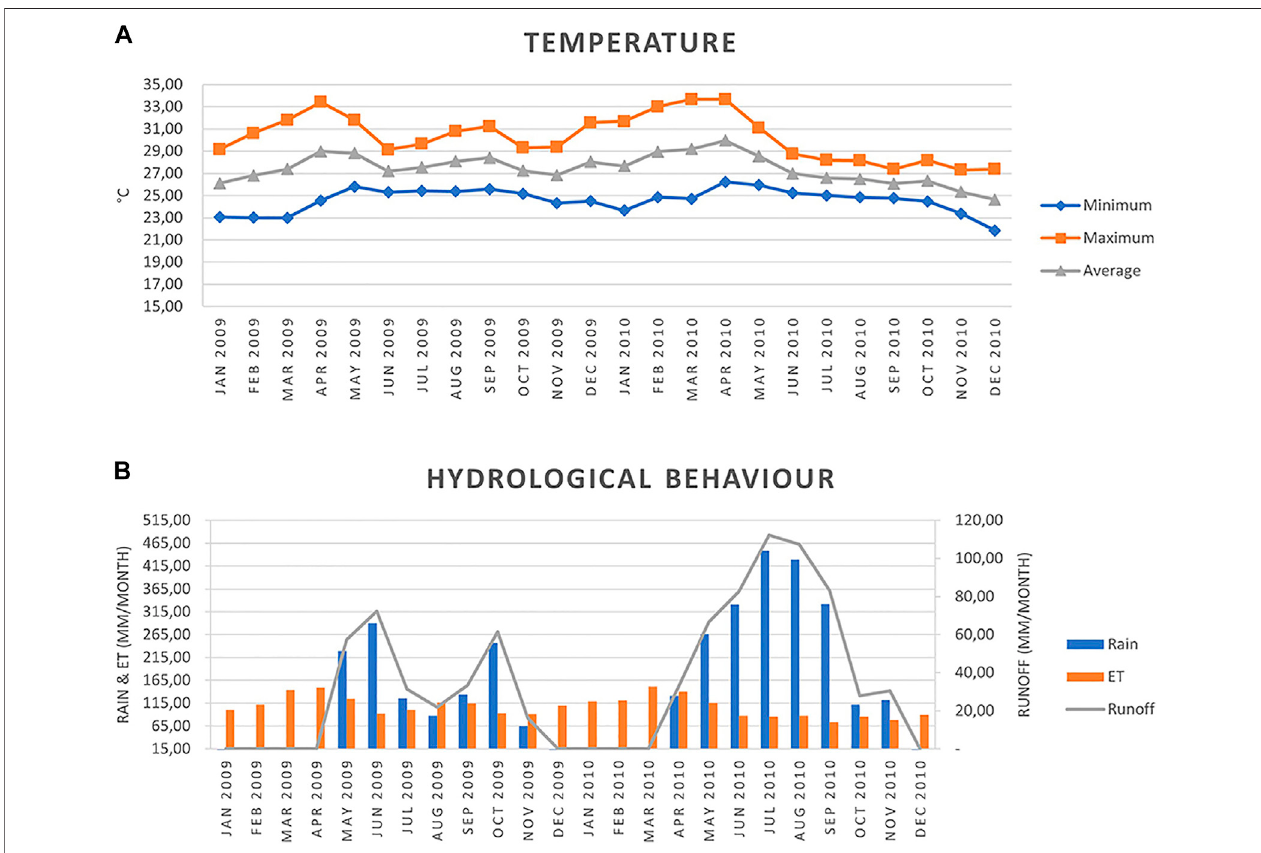
FIGURE 4 | (A) Temperature variation and (B) hydrological behaviour (rainfall, evapotranspiration, and runoff) January 2009-December 2010 for the sampled area of the Colorado and Las Palmas rivers (0.5 ° × 0.5 ° grid cell at 10.66 ° N and − 85.53 ° W).